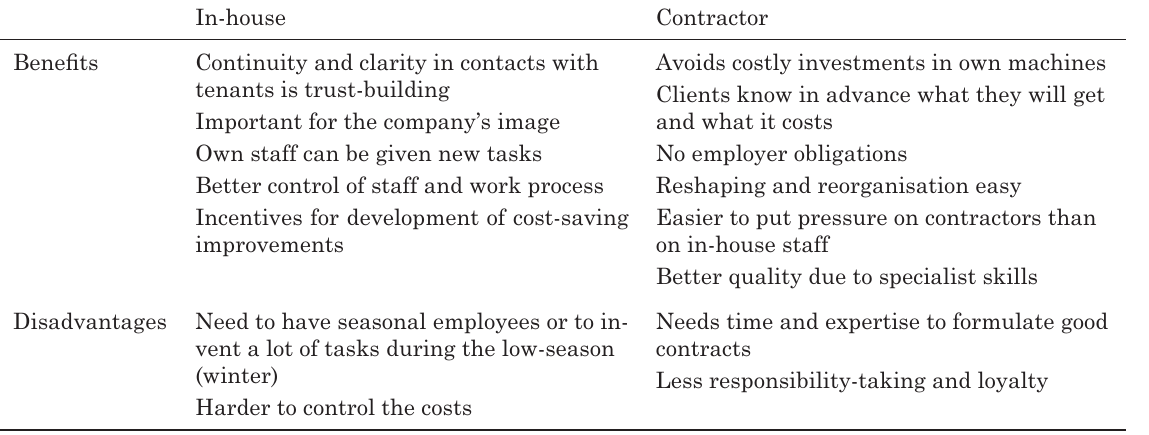
Table 2. Summary of arguments for and against in-house and contractor management In-house Contractor Benefi